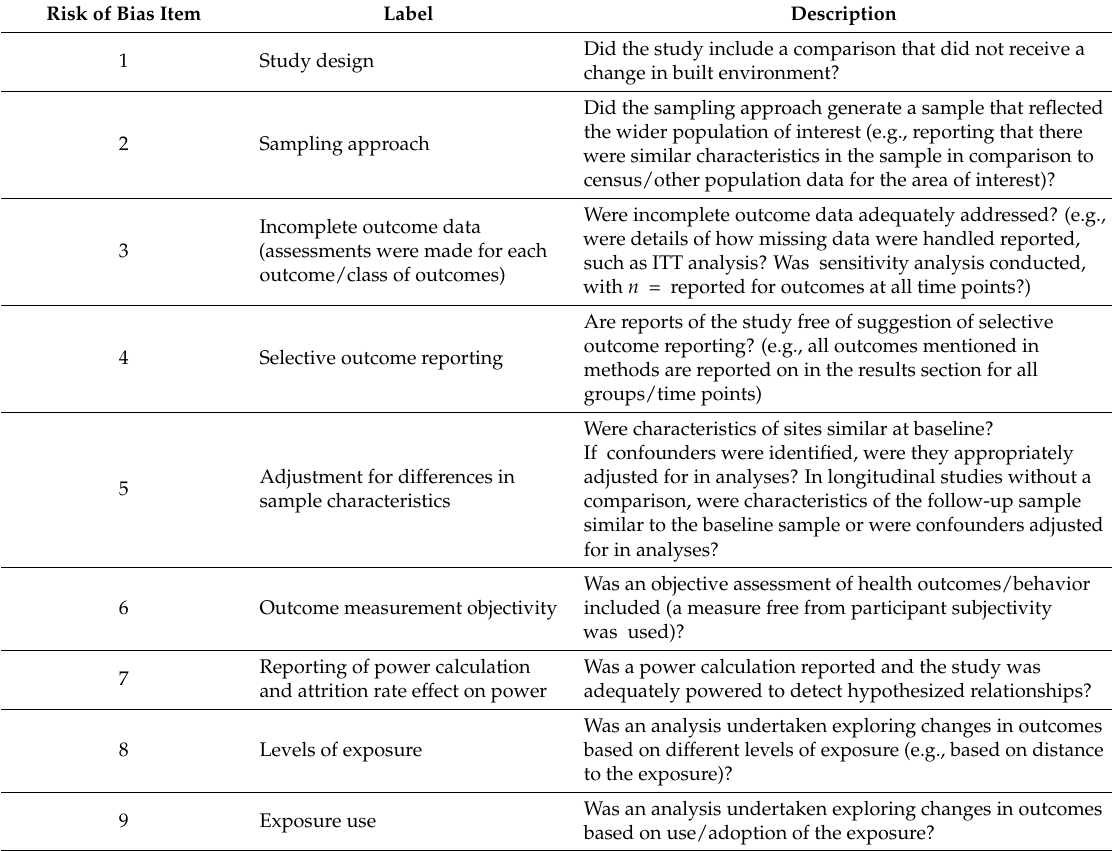
Table 1. Risk of bias item